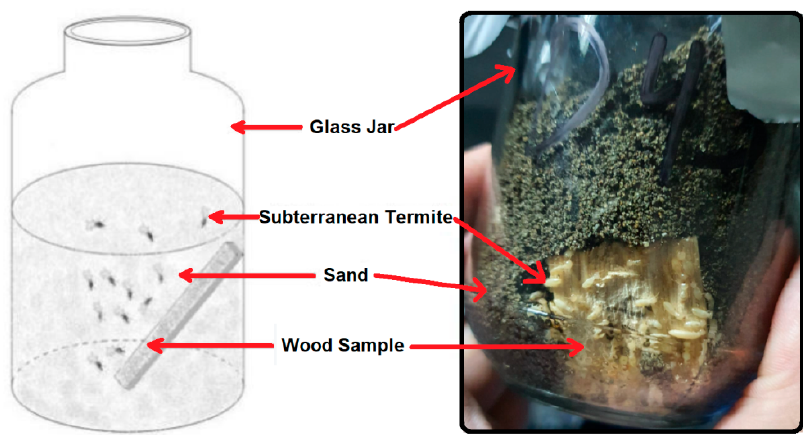
Figure 2. Test unit of subterranean termite attack on the wood specimen.